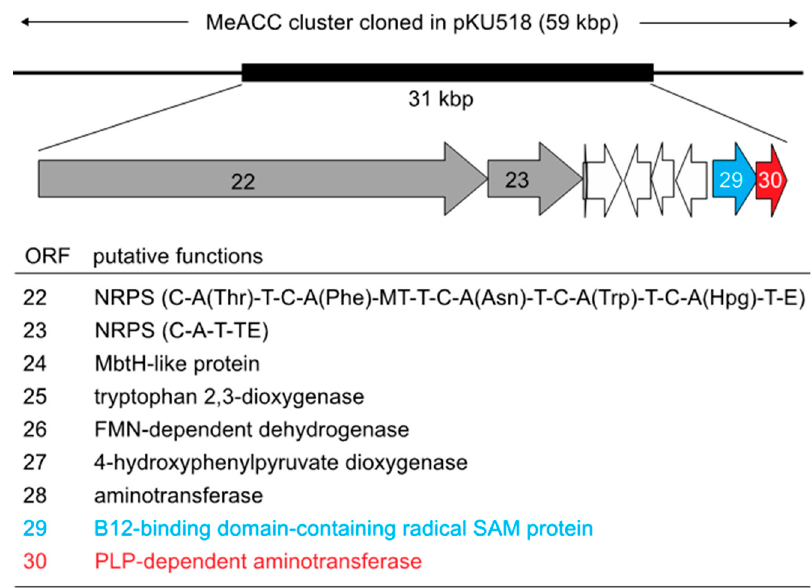
Figure 2. Gene organization of the MeACC cluster. The 59k bp DNA fragment was deposited in the DNA Database of Japan (DDBJ), European Molecular Biology Laboratory (EMBL), and GenBank databank under accession number LC535008. Condensation domain (C); thiolation domain (T; peptide carrier protein domain); methyltransferase domain (MT); epimerase domain (E), and thioesterase domain (TE).